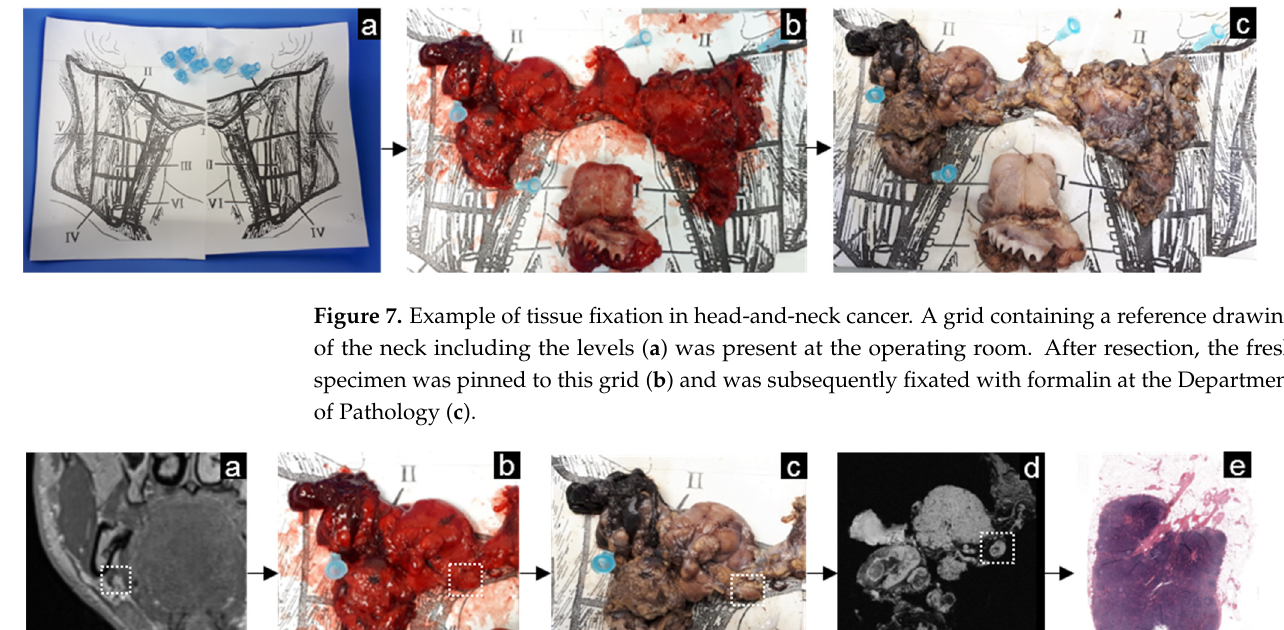
9 of 14 Figure 6. Example of the workflow in esophageal cancer. Lymph nodes were identified on the in vivo MRI after neoadjuvant chemoradiotherapy ( a ). Nodes could be matched using corresponding anatomical landmarks to the surgical specimen ( b ) and ex vivo MRI ( c , d ). The lipid-selective ( c ) and water-selective ( d ) ex vivo MRI guided the pathologist towards the lymph nodes for histopatholog- ical analysis of each node with hematoxylin and eosin staining ( e ). The white dashed lined box on the ex vivo MRI ( c , d ) and pathology ( e ) contains a healthy lymph node with USPIO contrast (the USPIO surgery interval was 1 day). Therefore, the lymph node lost its signal intensity on the water- selective image. 3.5. Head-and-Neck Cancer In the head-and-neck cancer patient, the neck dissection specimen was taken out en- bloc. The primary tumor was resected separately. After resection, the specimen was pinned to a grid with a reference drawing of the neck, including its anatomical nodal lev- els, and fixated with formalin (Figures 7 and 8). Next, the different neck levels were sepa- rated. To maintain orientation, pieces were vacuum-sealed in their original configuration with a TissueSAFE plus system (Figure 3) and scanned ex vivo in the 7T preclinical MR system. The cuts, or the boundaries between the neck levels, were visible on ex vivo MRI.